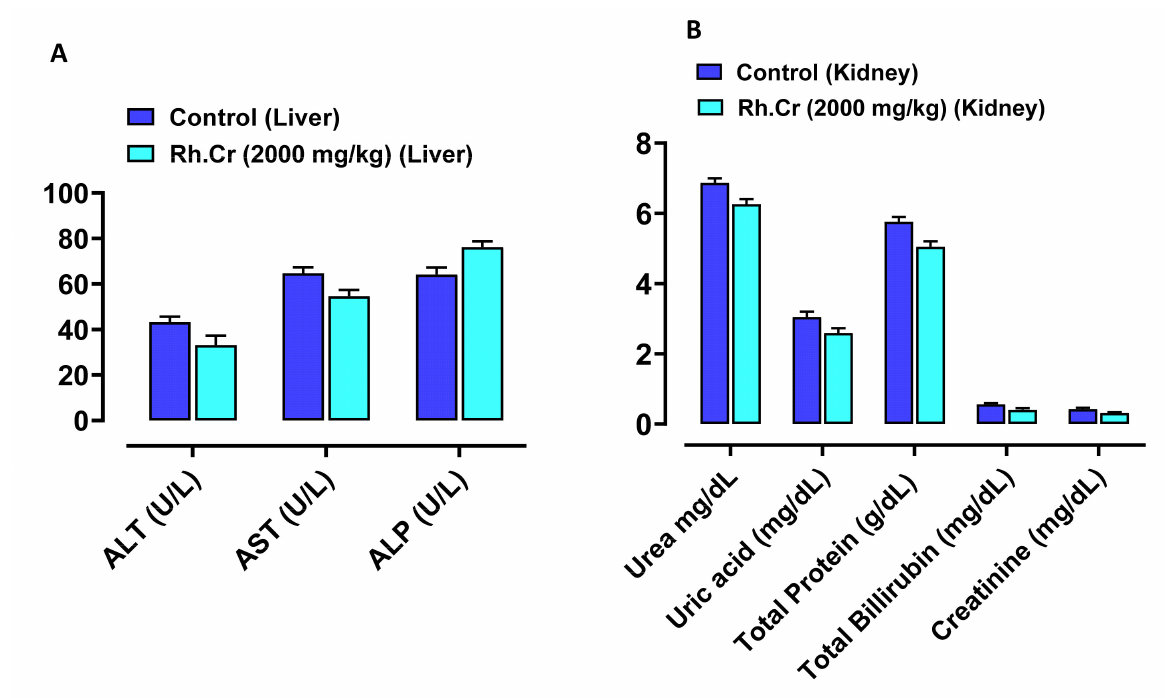
Figure 14. Effect of Rumex hastatus crude extract (Rh.Cr) against ( A ) liver function tests (LFTs) ALT (alanine aminotransferase), AST (aspartate aminotransferase) and ALP (alkaline phosphatase) ( B ) renal function tests (RFTs) of rats liver and kidney.